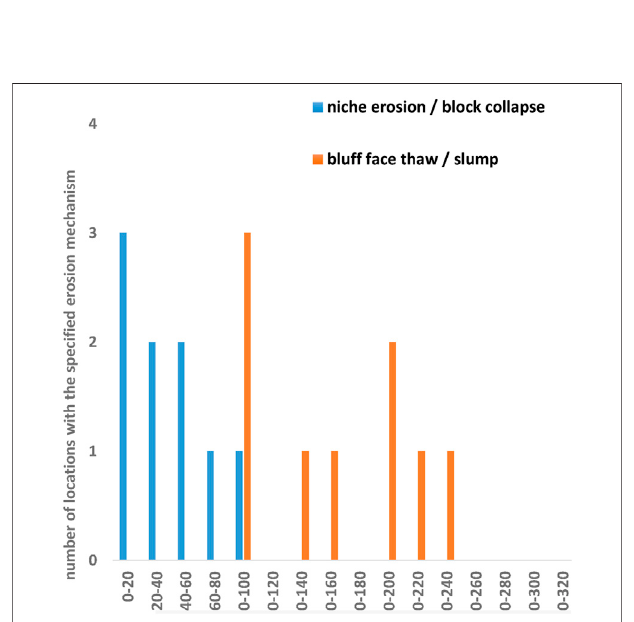
FIGURE 11 | A histogram showing the frequency of occurrence of the niche erosion/block collapse erosion mechanism and bluff face thaw/slump mechanism as a function of coarse sediment areal density.